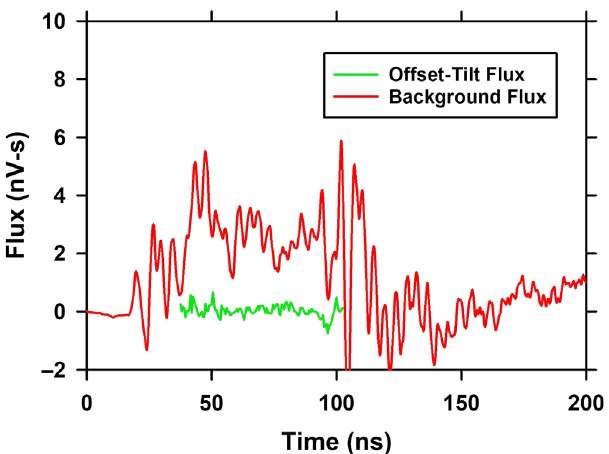
FIG. 15. Flux resulting from offset-tilt effect (green curve) compared with background flux (red curve). The offset-tilt flux is only shown during the current flattop because the calculation is subject to large timing error during the beam rise and fall. (This zero-bias shot 37853 was used as background for shot 37858